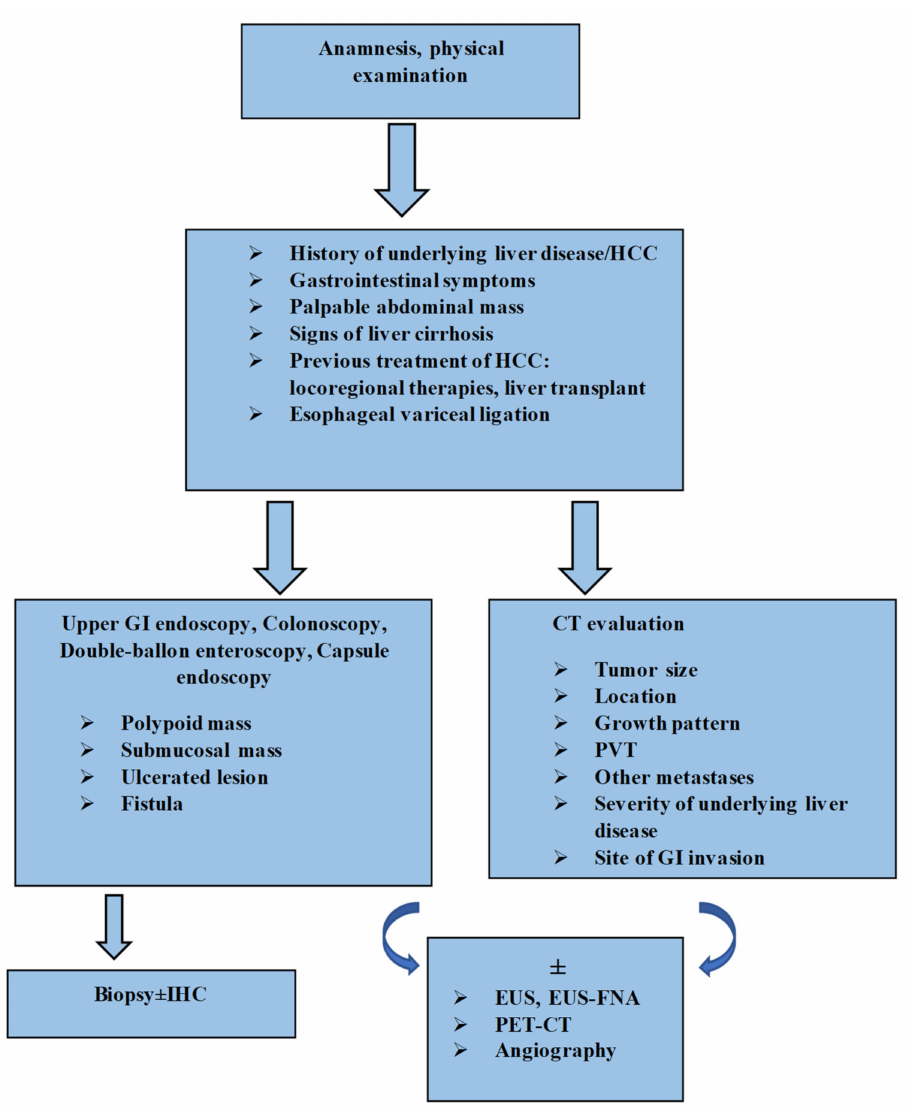
Figure 2. Algorithm for diagnosis of GI tract involvement from HCC. HCC: hepatocellular carcinoma; GI: gastrointestinal; CT: computed tomography; PVT: portal vein thrombosis; IHC: immunohisto- chemistry; EUS: endoscopic ultrasound; EUS-FNA: endoscopic ultrasound-fine needle aspiration; PET-CT: positron emission tomography-computed